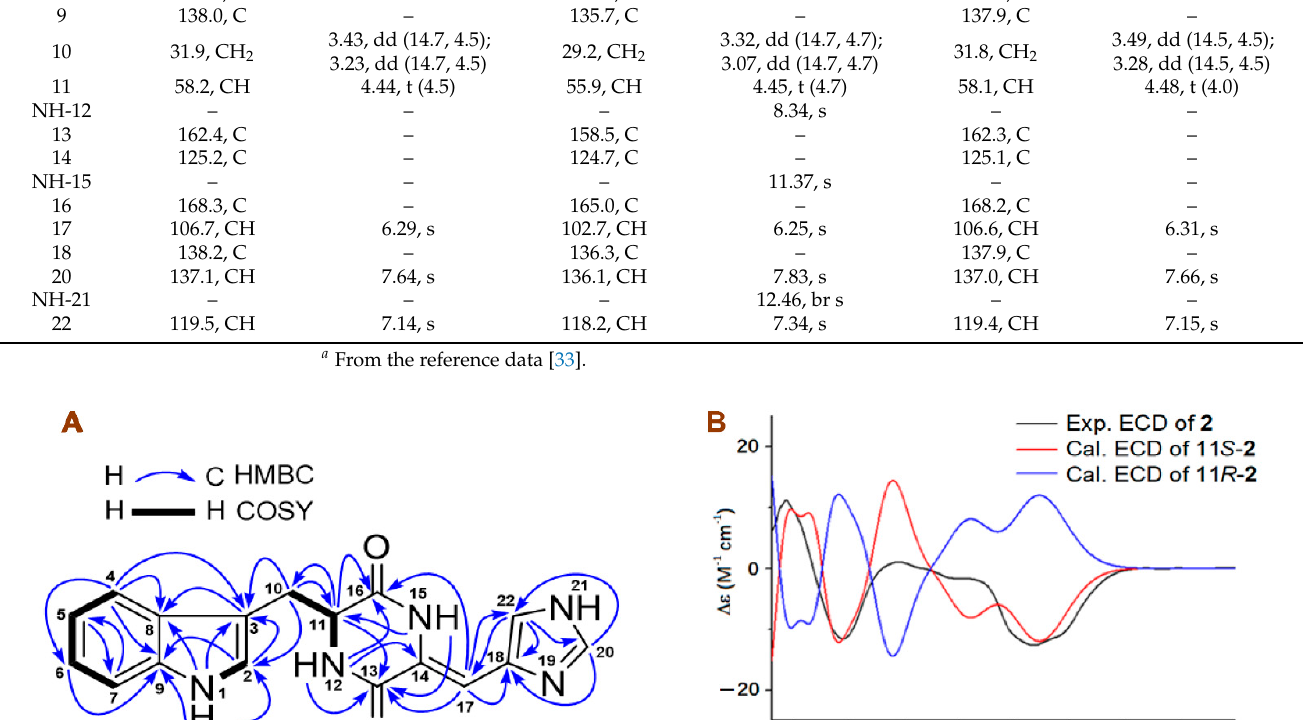
value, and penilloid A should have a 11 R -configuration. The 11 S -configuration for 2 was further confirmed by ECD calculated results (Figure 5 and Tables S19–S22), because the experimental ECD spectrum of 2 showed good agreement with the calculated ECD curve of the model molecule of 11 S - 2 . The geometry of the C 14 -C 17 can be assigned based on the chemical shift difference ( ∆ δ C14-C18 ) between C-14 and C-18 [20,33]. Usually, an ∆ δ C14-C18 value of over 10 ppm indicated a 14 Z -geometry; while an ∆ δ C14-C18 value of less 5 ppm was suggestive of an E -geometry. As shown in Table 2, the ∆ δ C14-C18 values in MeOH- d 4 and DMSO- d 6 were 13.0 and 11.6 ppm, respectively, indicating a 14 Z -geometry for 2 . Based on the foregoing evidence, the structure of 2 was elucidated as a new indole diketone Figure 4. The experimental ECD spectrum of penipyridinone B ( 1 ) in MeOH and the calculated ECD piperazine alkaloid, named 11 S -( − )-penilloid A. curves of four model molecules 1f, 1g ( A ) , 1h and 1i ( B ) at the b3lyp/6-311+g (d, p) level in MeOH. Compound 2 was obtained as a yellow amorphous solid and had a molecular Table 2. 13 C NMR (150 MHz) and 1 H NMR (600 MHz) data of 11 S -( − )-penilloid A ( 2 ) and penilloid A. formula C 17 H 15 N 5 O 2 deduced from its HRESIMS ion peaks at m/z 322.1298 [M + H] and 2 (in DMSO- d 6 ) 344.1118 [M + Na], as well as from 13 C NMR data. Careful interpretation of its 13 C and 1 H NMR data (Table 2) as well as the COSY and HMBC correlations (Figure 5) demonstrated that 2 had the same planar structure as that of a known indole alkaloid penilloid A [33]. However, the configuration at C-11 of penilloid A was not determined, although its positive optical rotation (OR) value (+218.2, c 0.06, MeOH) was reported, which was opposite to the negative OR value ( − 201.6, c 0.16, MeOH) of 2 . Therefore, OR calculations [34,35] were used to assign the configuration at C-11, the only chiral carbon in 2 . The OR calculated results (Tables S15–S18) showed a positive OR value (+697.42) for 11 R and a negative OR value ( − 697.60) for 11 S. Accordingly, a 11 S -configuration was assigned for 2